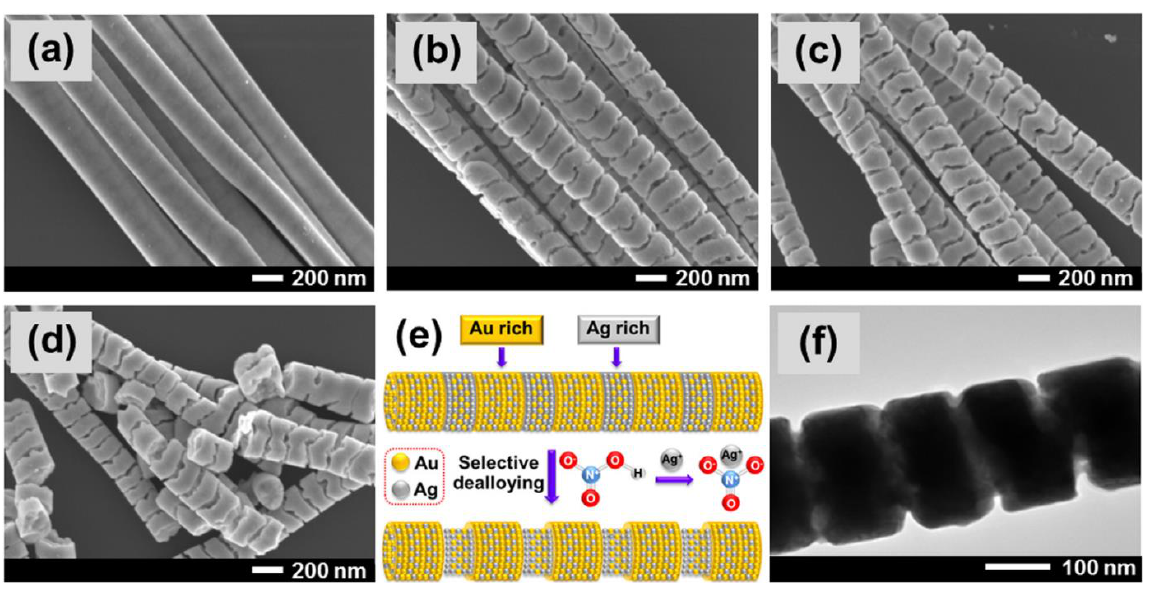
Figure 17. ( a – d , f ) SEM images of porous Au-Ag striped nanowires made through the interlaced electrodeposition supplemented with acid etching and ( e ) schematic of performed selective dealloying. Reprinted with permission from [223]. Copyrights 2019 Elsevier.